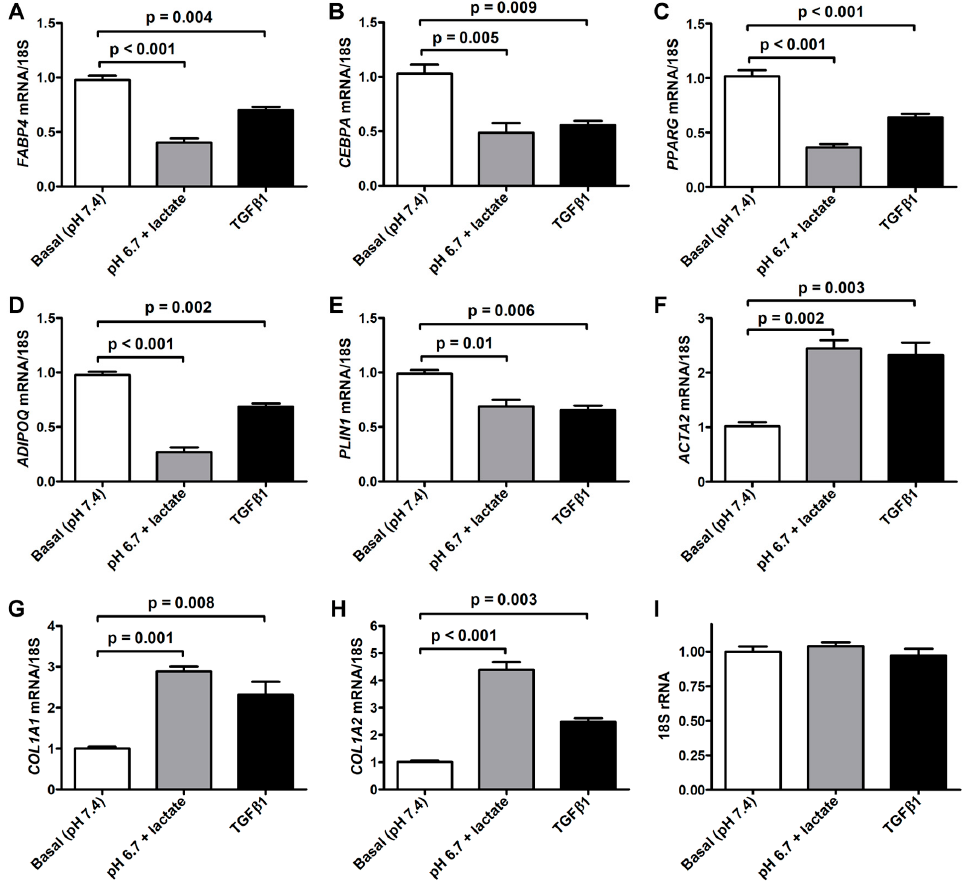
Figure 3. Quantitative real-time PCR analysis for the expression of the adipocytic genes FABP4 ( A ), CEBPA ( B ), PPARG ( C ), ADIPOQ ( D ), and PLIN1 ( E ) and the myofibroblastic genes ACTA2 ( F ), COL1A1 ( G ), and COL1A2 ( H ) in adipocyte-committed adipose-derived stem cells grown for 3 days under basal conditions (pH 7.4), lactic acidosis (pH 6.7 + lactate), or in the presence of 10 ng/mL TGF β 1. The basal level of each gene expression was set to 1, and the other results are normalized to this value. 18S ribosomal RNA (rRNA) was used as the reference gene. The expression levels of 18S rRNA were stable under the three different experimental conditions ( I ). Bars represent the mean ± SEM of three independent experiments ( n = 3 replicates each) from three cell lines. Values of p were determined by Tukey’s